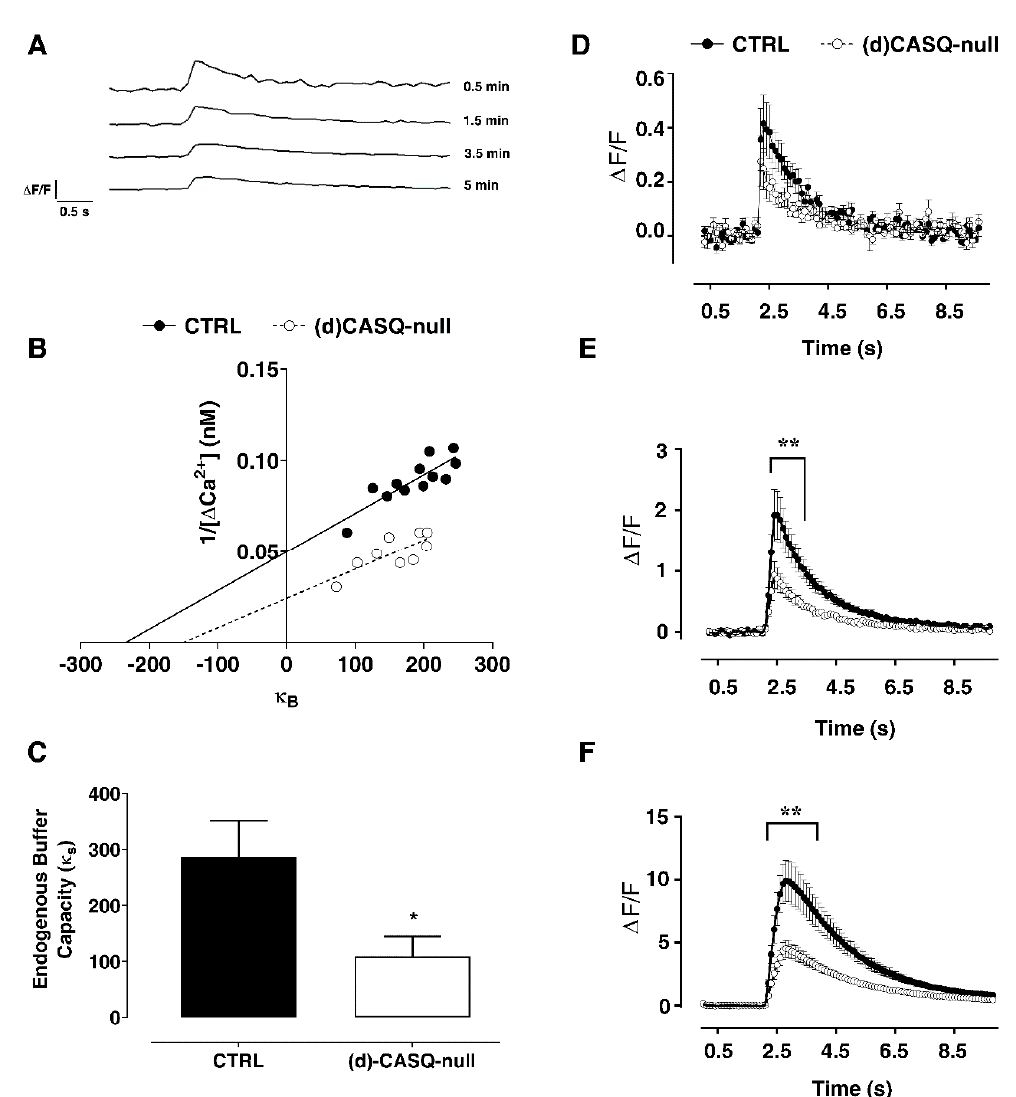
Figure 4. Calcium dynamics in CA1 pyramidal neurons. ( A ) Fluorescent transients elicited by single action potential at different time points after break-in ( Δ F/F). ( B ) Examples of inverse single action potential peak transient (1/ Δ [Ca 2+ ]) vs. added buffer capacity ( κ B ) during the loading phase for a neuron from CTRL and (d)CASQ-null mice. ( C ) The endogenous Ca 2+ buffer capacity ( κ S ) is shown. CTRL ( n = 7 cells from 4 animals) vs. (d)CASQ-null ( n = 6 cells from 3 animals). Student’s t-test: t(11) = 2.28, * p < 0.05. ( D – F ) Averaged (Ca 2+ ) transient elicited by a single action potential and by the action potential trains of 20 Hz (E) and 100 Hz (F) recorded in CTRL ( n = 11 cells from 4 animals) and (d)CASQ-null mice ( n = 10 cells from 4 animals). Two-way ANOVA test: 20 Hz, F(1, 19) = 10.82 p < 0.01; Sidak’s multiple comparisons test ** p < 0.01 (from 2.3 s to 3.4 s); 80Hz, F(1, 18) = 10.57 p < 0.01; Sidak’s multiple comparisons test ** p < 0.01 (from 2.4 s to 4.3 s).